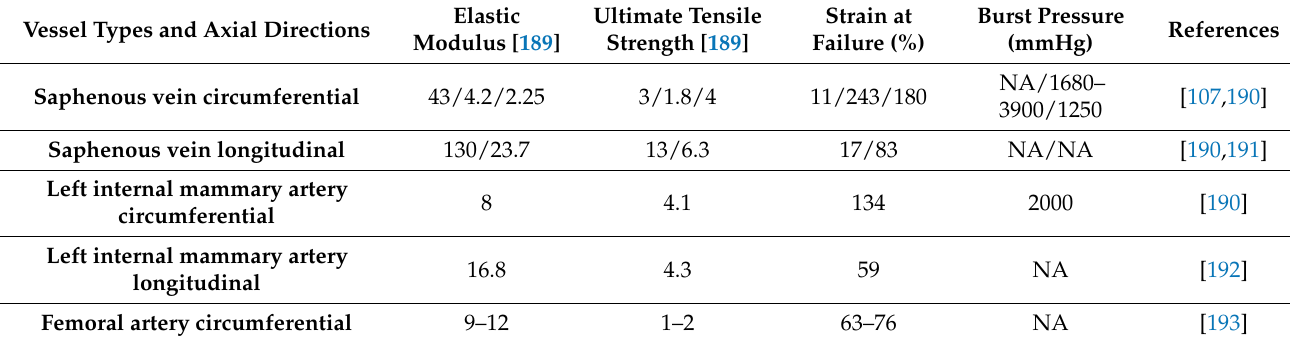
Table 2. Mechanical Properties of Native Blood